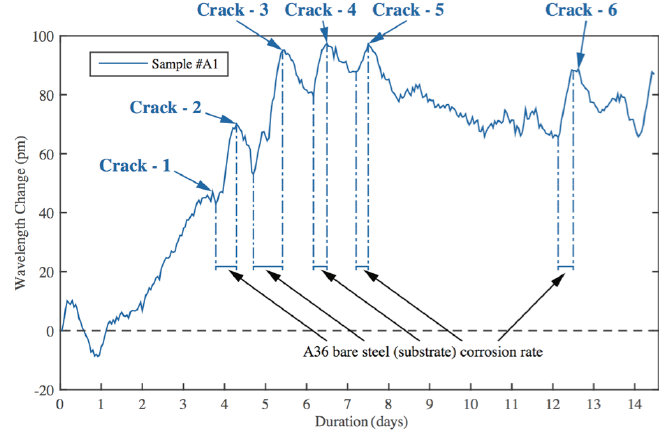
Figure 15. Change of wavelength curves in FBG sensor due to existence of the cracks.